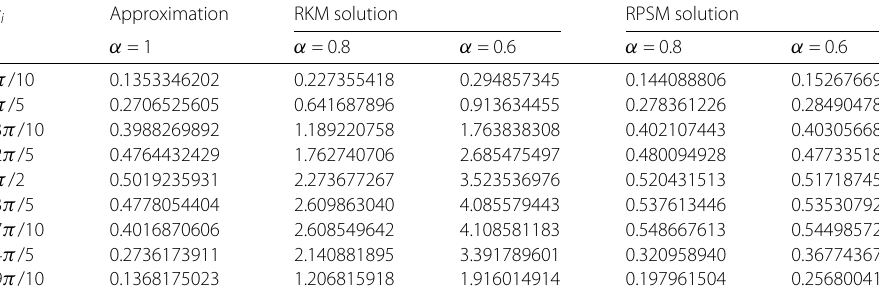
Table 4 Numerical results of BVP (4.3) for different values of